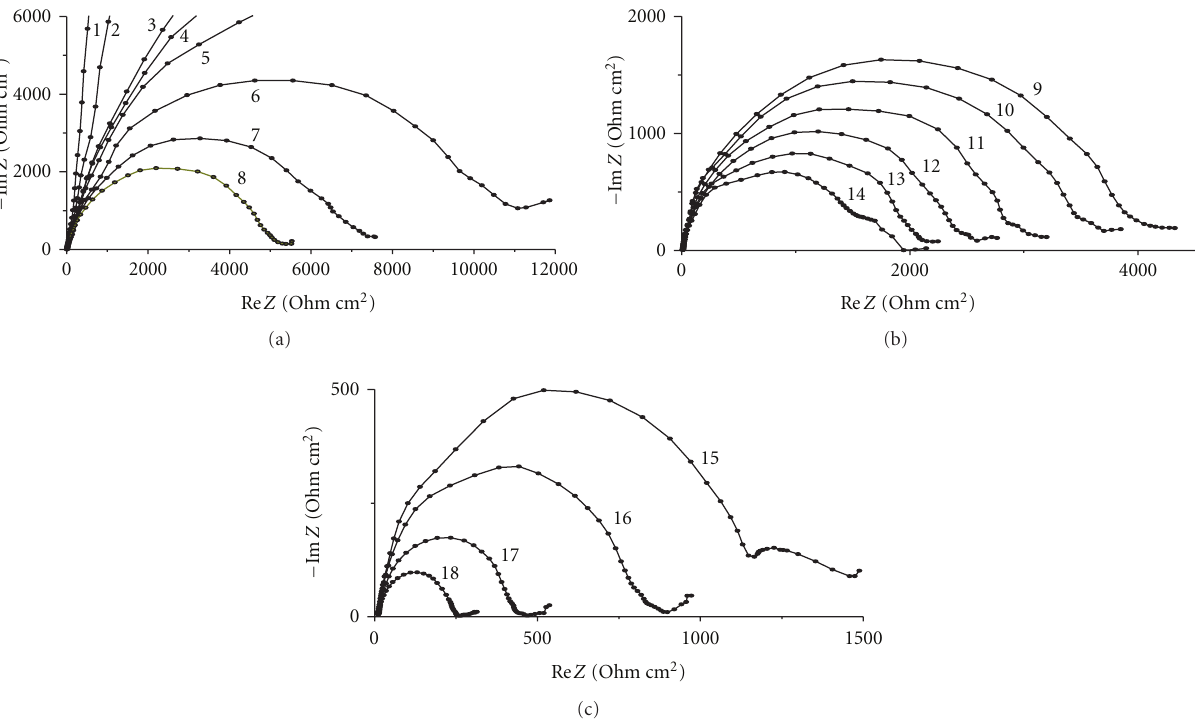
Figure 3: (a)–(c) Complex-plane plots of impedance spectra ( f -sweep) in 0.5 M K 2 SO 4 benzene-free solution at potentials E : (1) 0.80V; (2) 1.40V; (3) 1.60 V; (4) 1.65 V; (5) 1.70 V; (6) 1.75 V; (7) 1.80 V; (8) 1.85V; (9) 1.95 V; (10) 2.00 V; (11) 2.05 V; (12) 2.10 V; (13) 2.15 V; (14) 2.20V; (15) 2.25 V; (16) 2.30 V; (17) 2.35 V; (18) 2.40